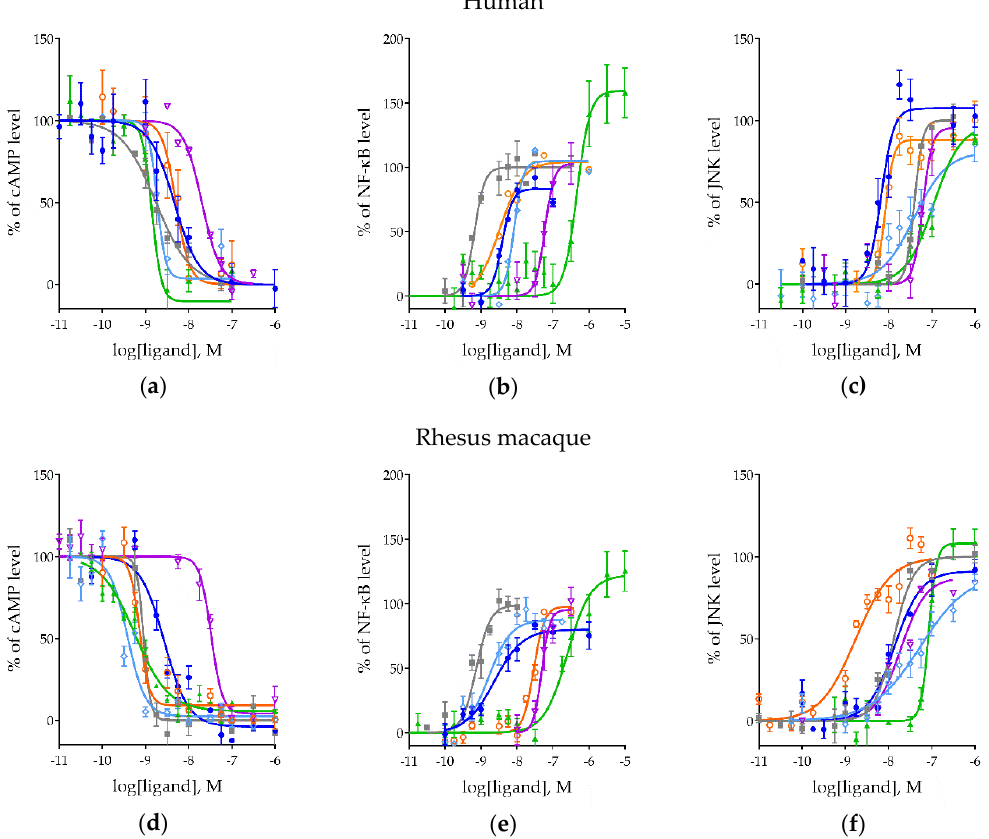
Figure 2. The concentration-dependent inhibition/activation of signaling by MOR ligands. Inhibition of forskolin-induced cAMP activation in human ( a ) and rhesus macaque ( d ) MORs. Stimulation of NF-kB in human ( b ) and rhesus macaque ( e ) MORs. Stimulation of MAPK/JNK in human ( c ) and rhesus macaque ( f ) MORs. Morphine (blue), met-enkephalin (cyan), endomorphin-1 (orange), β -endorphin (purple), and TRV130 (green). Table 1 . Summary of ligand potencies and efficacies in human and rhesus macaque MORs.